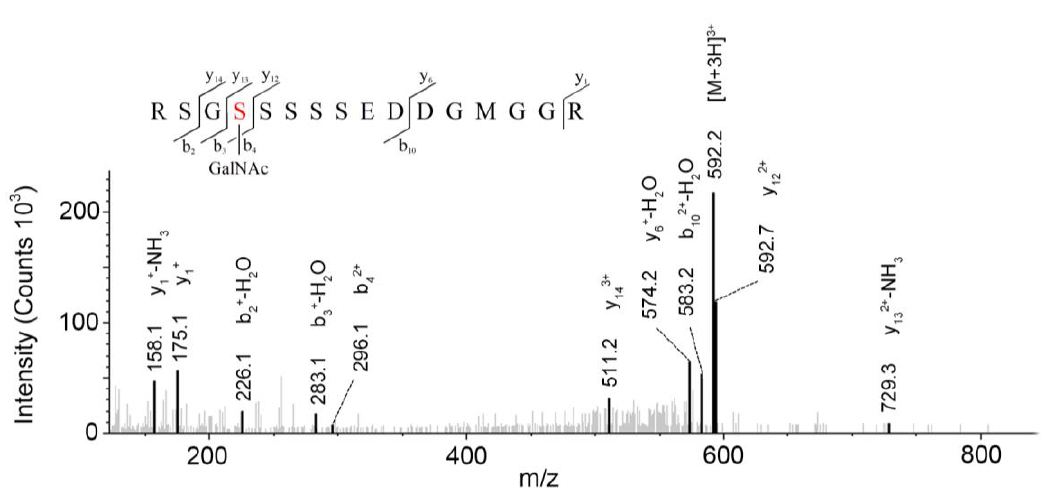
Table 2. Structures of the major glycopeptides from Gg. Linkage Structures of Glycopeptides *